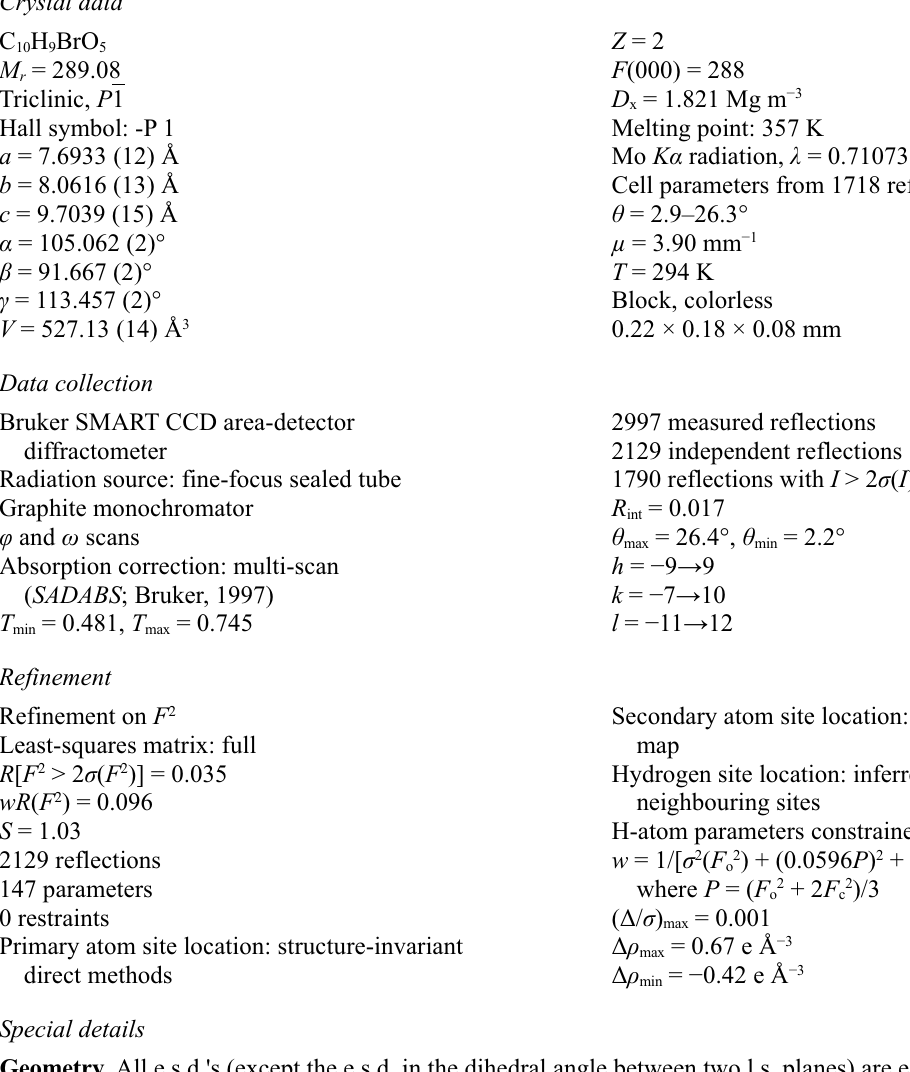
Figure 1 View of (I) showing the atom-labelling scheme. Displacement ellipsoids are drawn at the 35% probability level. Methyl 6-bromo-7-methoxy-1,3-benzodioxole-5-carboxylate Crystal